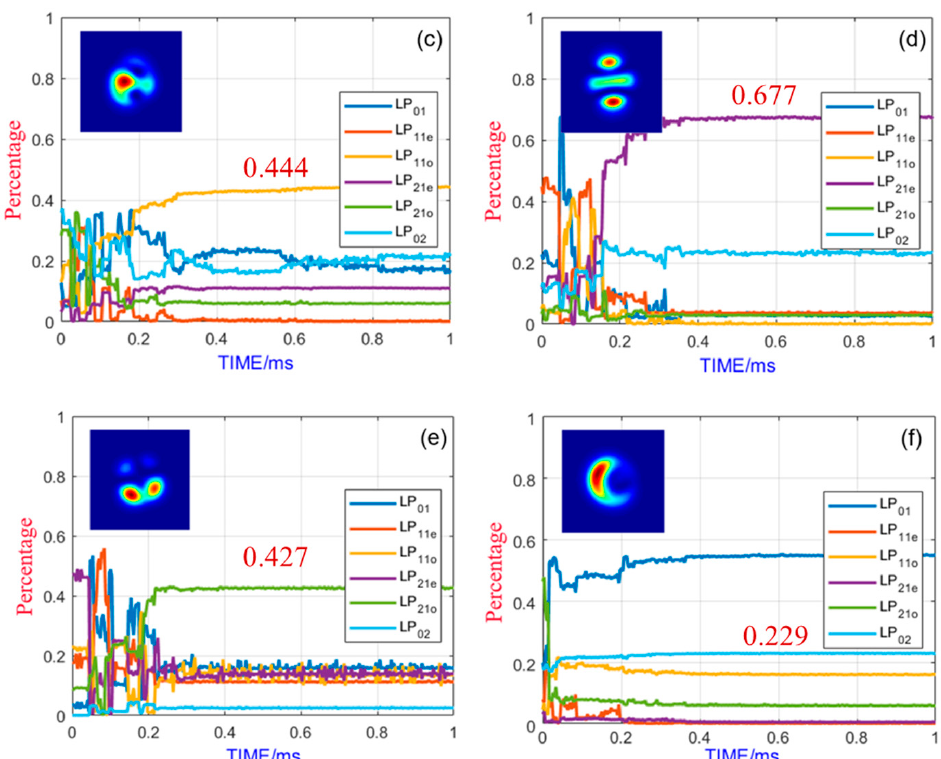
Figure 3. Mode content evolution of 6 × 1 photonic lantern initialized by the random amplitudes, where the desired mode is chosen as the evaluation function. ( a ) LP 01 , ( b ) LP 11e , ( c ) LP 11o , ( d ) LP 21e , ( e ) LP 21o , and ( f ) LP 02 . The time window is set to 1 ms as the curves mostly stabilize.